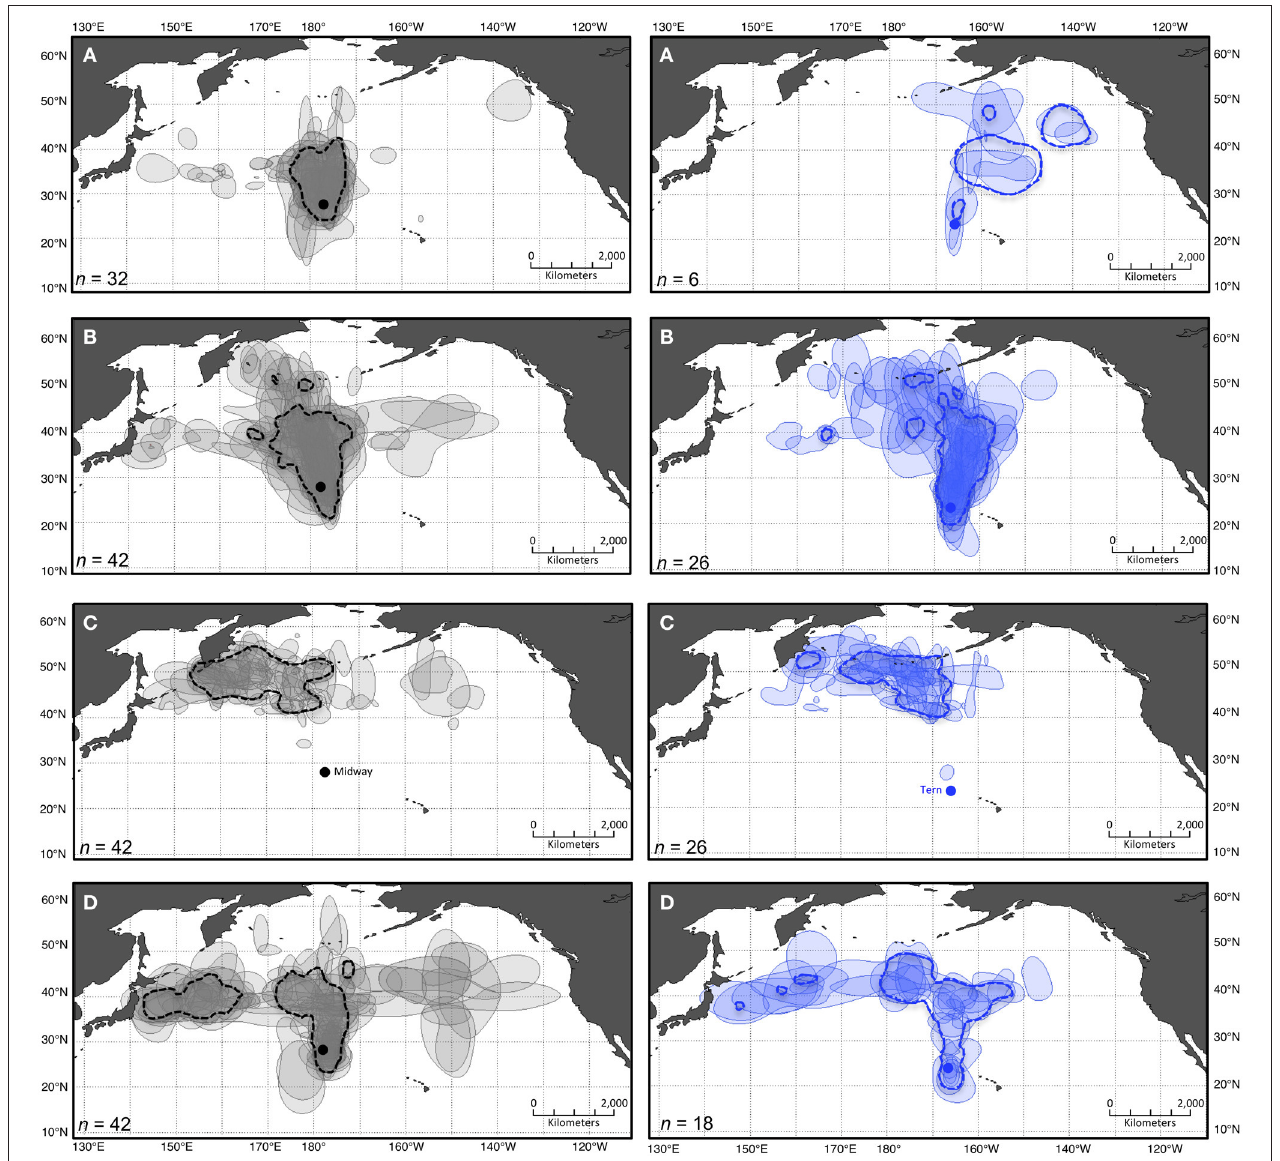
FIGURE 2 | Pooled and stacked 50% kernel contours for two colonies of Laysan albatross during four periods of the annual cycle. Dashed polygons show 50% kernel contours from pooled KDE including GLS location data from all individual Laysan albatross tracked from Midway (left panes in gray) and Tern (right panes in blue) during four periods of the annual cycle: (A) ECR, (B) LCR, (C) OW, and (D) PBE (see Figure 1 ). Shaded polygons show 50% contours from individual KDE including data from each bird independently. The lightest shade indicates areas used by a single individual, and the darkest indicates areas of most intense overlap among individuals. Colonies are indicated in panels (C) by solid circles in their respective colors (projection: Lambert Cylindrical Equal Area, datum: